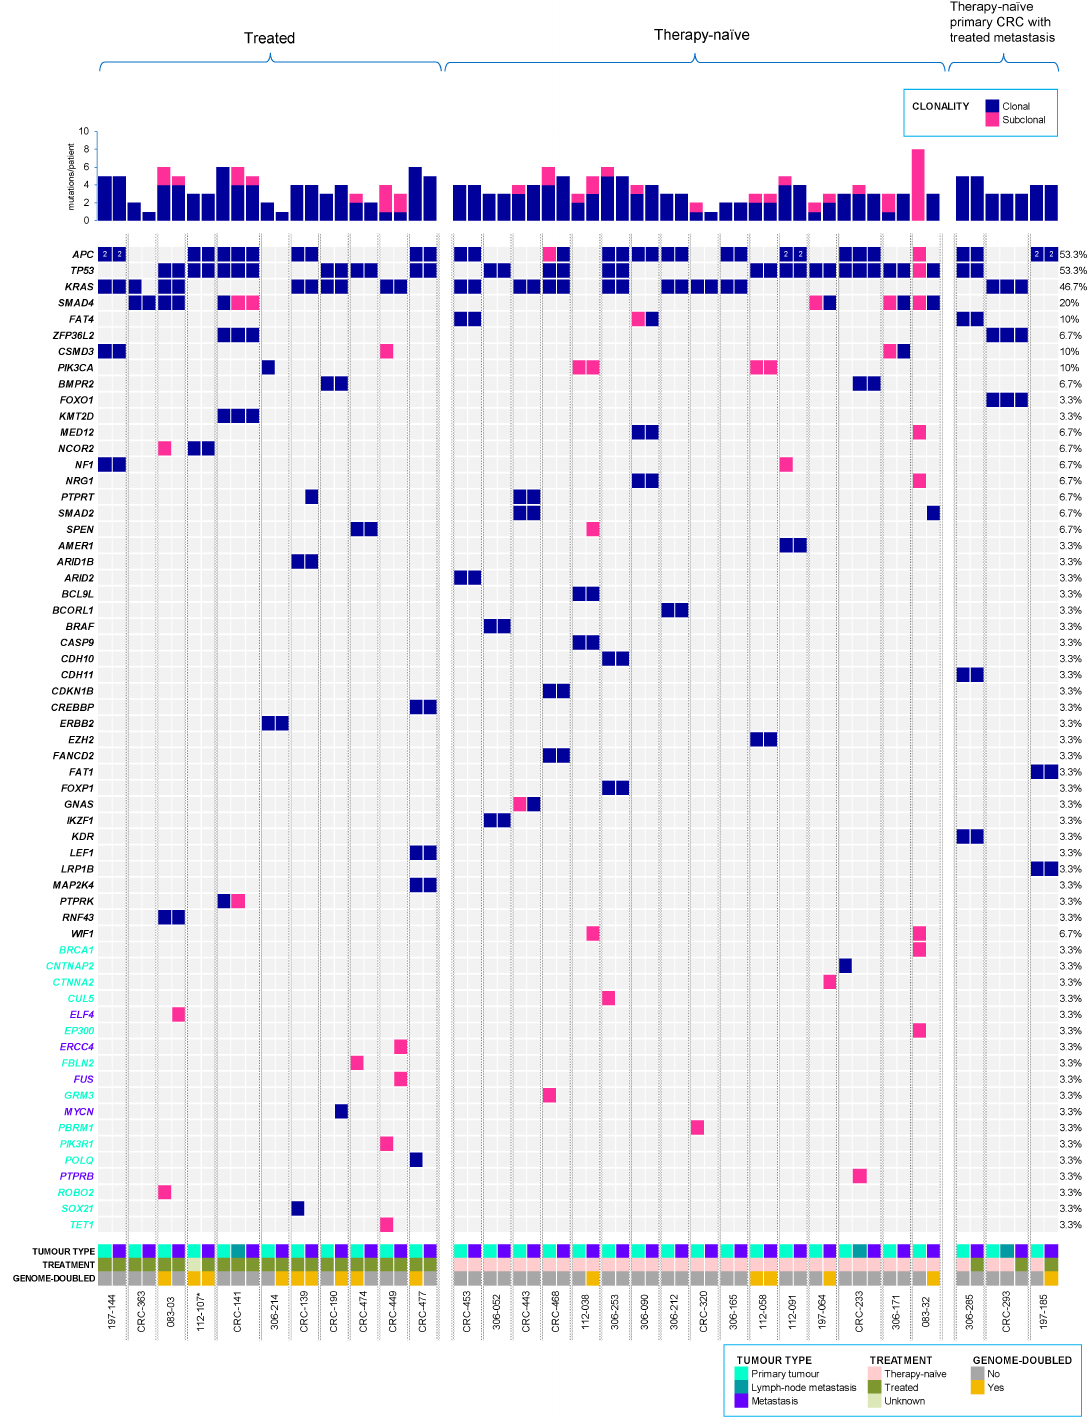
Figure 2. Driver mutations in metastatic colorectal cancer (CRC) cohort. All clonal and subclonal driver mutations (including single nucleotide variants—SNVs, and small insertions and deletions—Indels) detected for each CRC primary and corresponding metastasis, including lymph node metastasis, where relevant. The top panel displays the number of driver mutations / patient identified across tumours, whereas the right panel shows the percentage of driver mutations / gene. Primary-specific (turquoise) and metastasis-specific (purple) driver genes are indicated on the left panel. Treatment status and genome-doubling are also provided. The treatment status of the primary tumour of patient 112-107, marked by an asterisk (*), was not